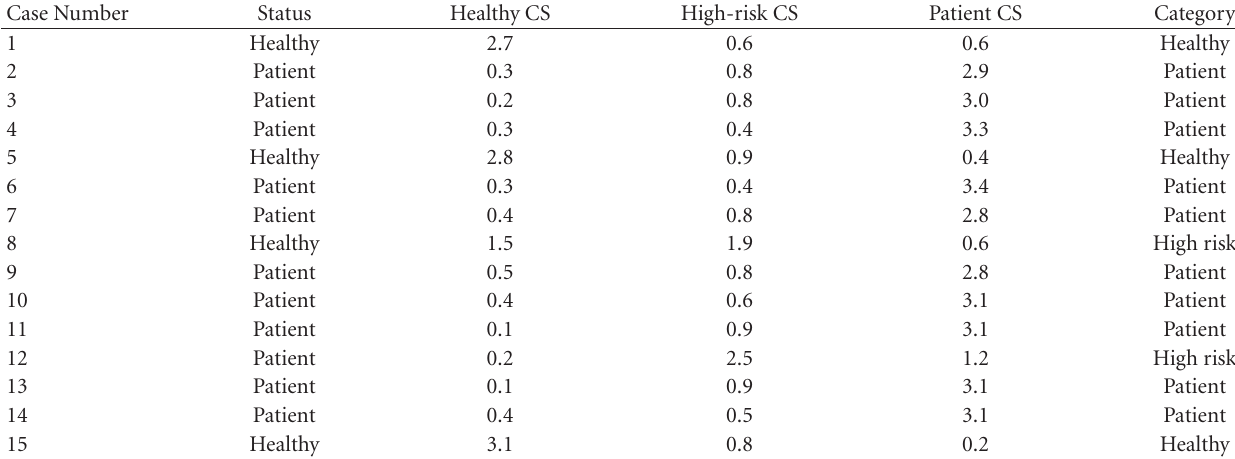
Table 5: Results of algorithm testing on the second group.